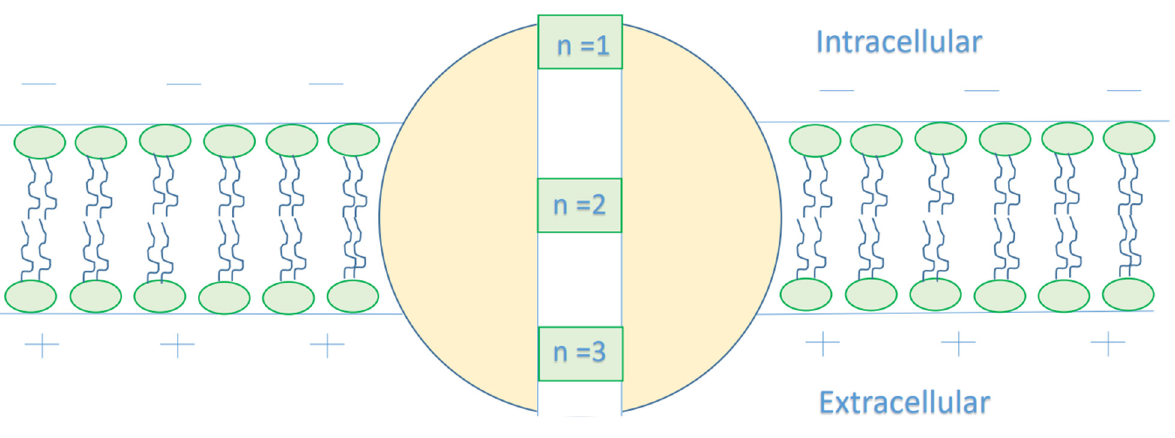
Figure 3. The figure represents different locations of the closed gate in the GABA receptor. The gate location affects the kinetic energy of the chloride ion once it reaches the closed gate. As the n value increases, the membrane potential available to enhance the kinetic energy of the intracellular anion increases, hence its kinetic energy increases. On the other hand, as the n value increases, the membrane potential available to dampen the kinetic energy of the extracellular anion decreases, hence the decrease in its kinetic energy is